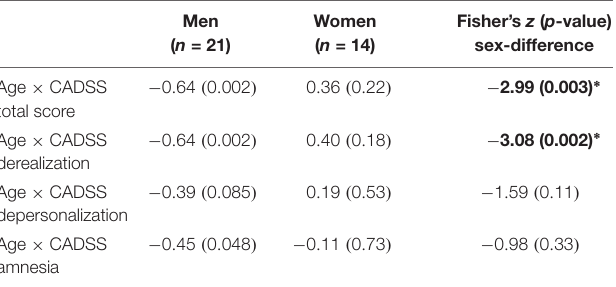
TABLE 2 | Correlation analyses testing sex-specific associations between Age and CADSS scores immediately after infusion. Men Women Fisher’s z ( p -value) ( n = 21) ( n = 14) sex-difference − 0 . 64 ( 0 . 002 ) 0 . 36 ( 0 . 22 ) − 2.99 (0.003) ∗ Age × CADSS total score − 0 . 64 ( 0 . 002 ) 0 . 40 ( 0 . 18 ) − 3.08 (0.002) ∗ Age × CADSS derealization − 0 . 39 ( 0 . 085 ) 0 . 19 ( 0 . 53 ) − 1 . 59 ( 0 . 11 ) Age × CADSS depersonalization − 0 . 45 ( 0 . 048 ) − 0 . 11 ( 0 . 73 ) − 0 . 98 ( 0 . 33 ) Age × CADSS amnesia Women and men differed with respect to the CADSS total score and the subscale derealization. Clinician Administered Dissociative Symptoms Scale (CADSS). Data is presented as r coefficient (p-value). Bold values and ∗ indicate p <